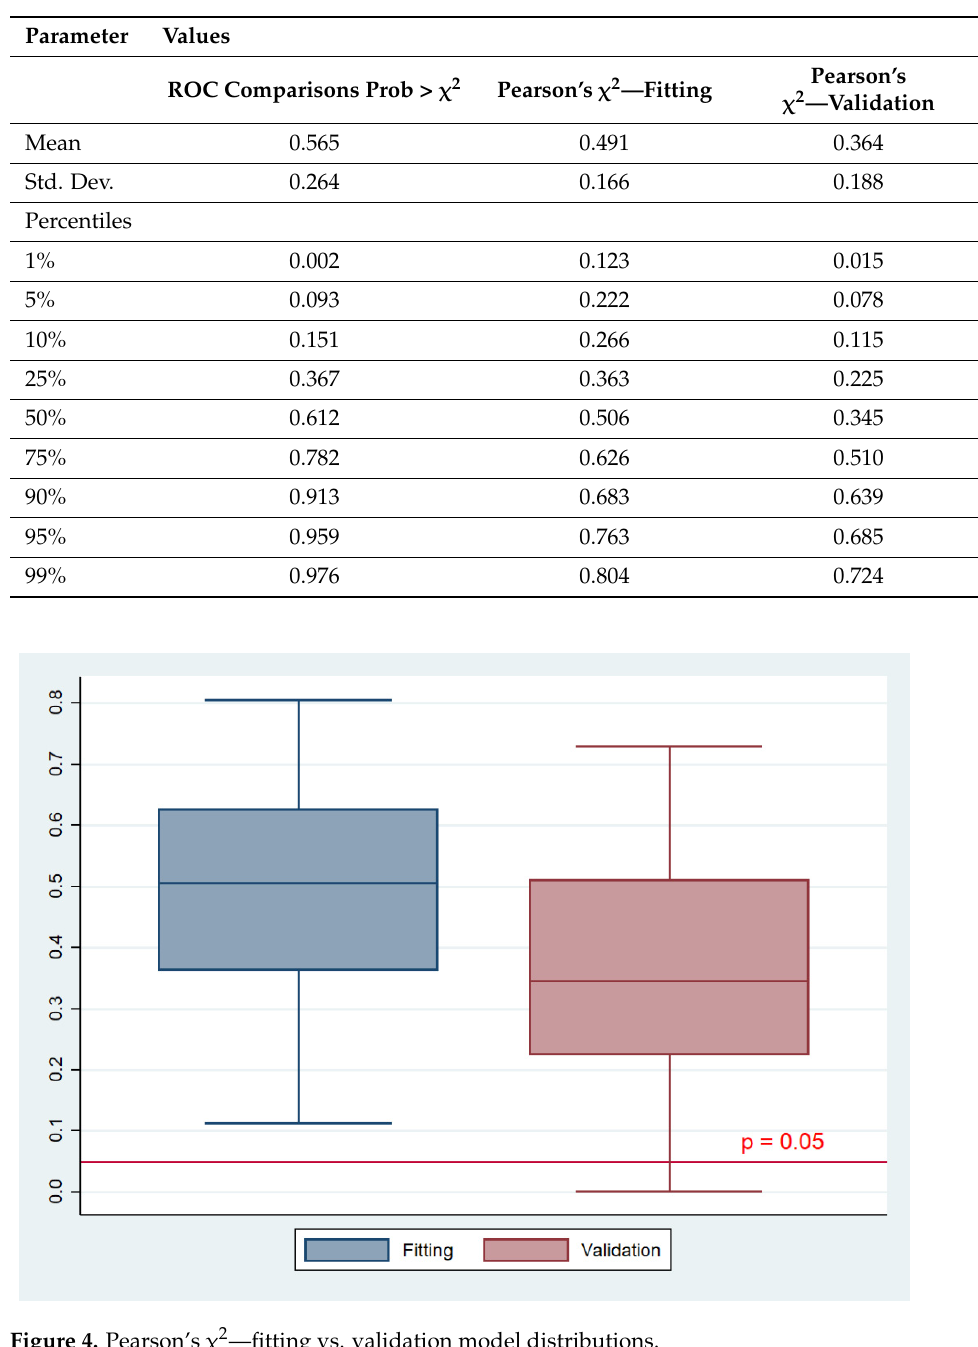
Table 10. Distribution of performance measures—firm pooled model validation.